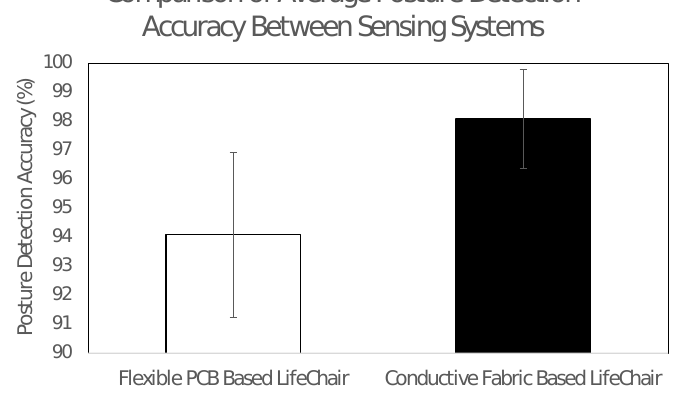
Figure 8. Comparison of average classification accuracies between sensing systems. The error bars are standard deviations ( F = 3.198, p =